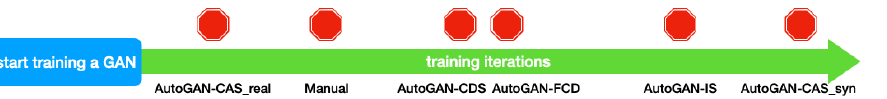
Figure 7. An example of when each alternative method might give the stop training signal to a given GAN.